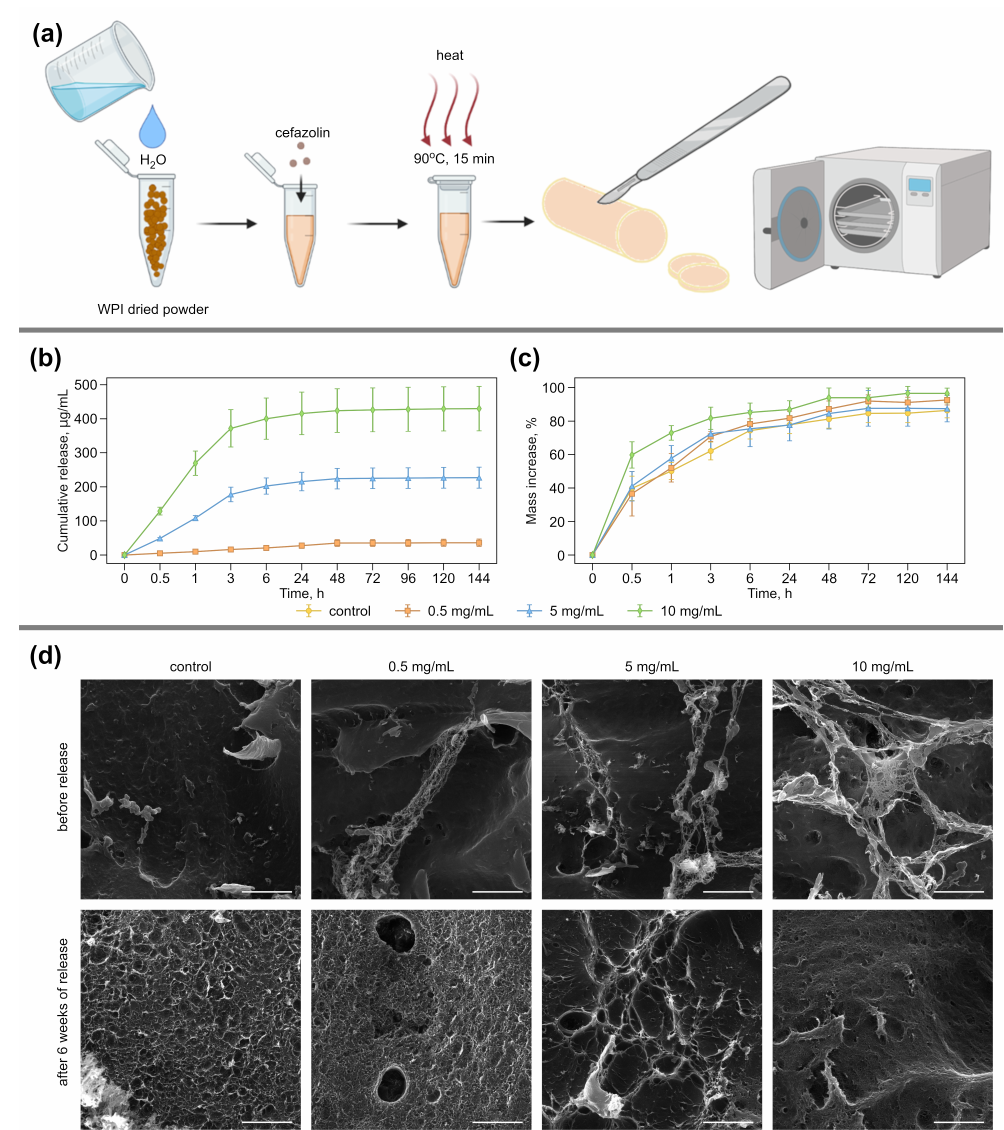
Figure 1. ( a ) The principal scheme for the formation of WPI-based hydrogels containing cefazolin. Control WPI hydrogels were prepared similarly without the addition of antibiotics. ( b ) The cefazolin cumulative release profile from WPI hydrogel disks incubated in saline at 37 °C for 144 h. Error bars show cumulative standard deviations calculated from five measurements for a sample in each treatment stage. ( c ) Mass increase (swelling profile) of WPI hydrogels containing cefazolin incubated in saline at 37 °C. Error bars show standard deviation, calculated from five measurements for a sample in each treatment stage. ( d ) Morphological analysis of WPI hydrogels with cefazolin. The scale bar for SEM images of transverse-sections is 5 µ